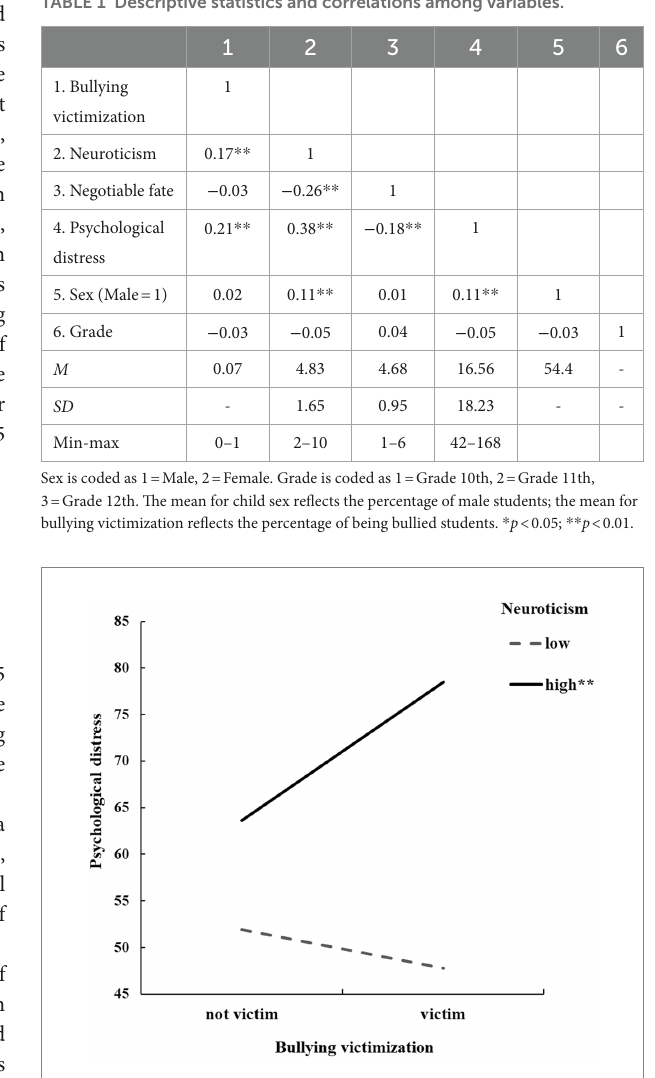
TABLE 1 Descriptive statistics and correlations among variables.